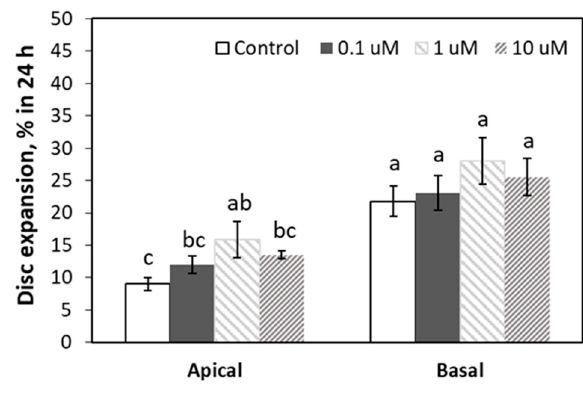
Figure 4. Area expansion of discs excised from the tip and base of pepper leaves after incubation for 24 h on solutions of 0.1, 1 and 10 GA 3 . Bars are the mean ± SE of 10 replicates. Different letters indicate significant ( p < 0.05) differences between treatments.